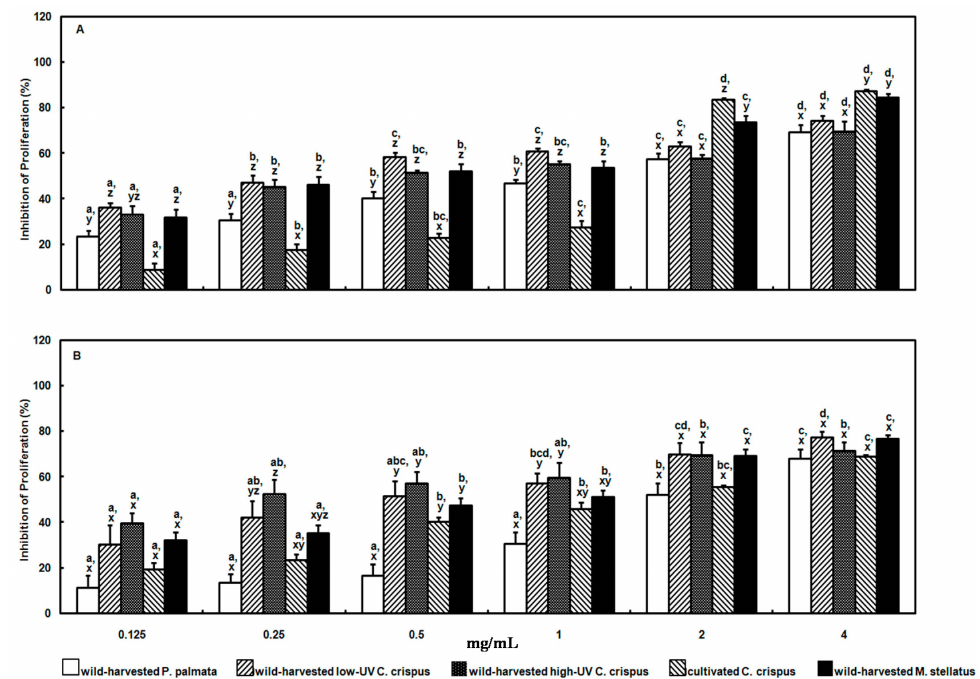
Figure 2. Effect of wild-harvested and cultivated red macroalgal extracts on the proliferation of human cervical adenocarcinoma HeLa (Panel A ) and histiocytic lymphoma U-937 (Panel B ) cells over 24 h. a–d indicate a significant difference ( p < 0.001) between concentrations of each red macroalgal extract; x–z indicate a significant difference ( p < 0.001) between the red macroalgal extracts at each concentration.